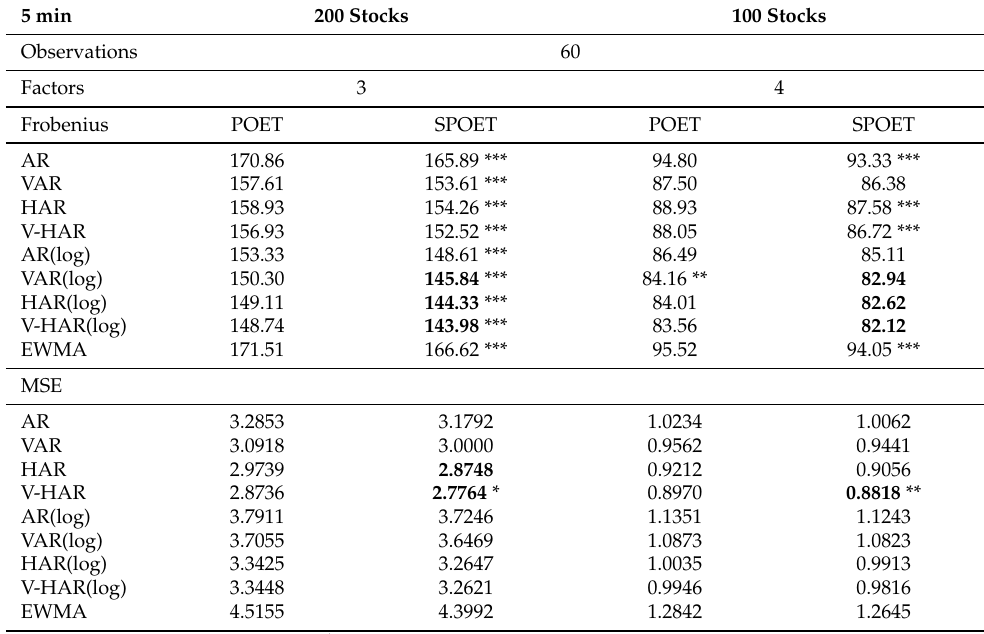
Table 4. Average forecasting losses for 5-min interval intraday